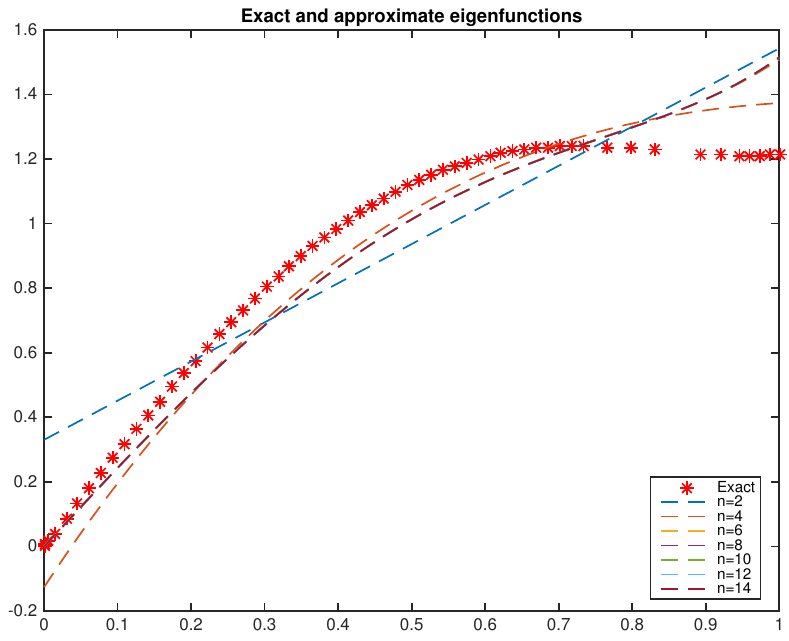
Figure 4. Exact and approximate eigenfunctions for the kernel K ( x , ξ ) = tan x sin3 ξ + sin3 x tan ξ over [ 0,1 ] 2 at various truncation